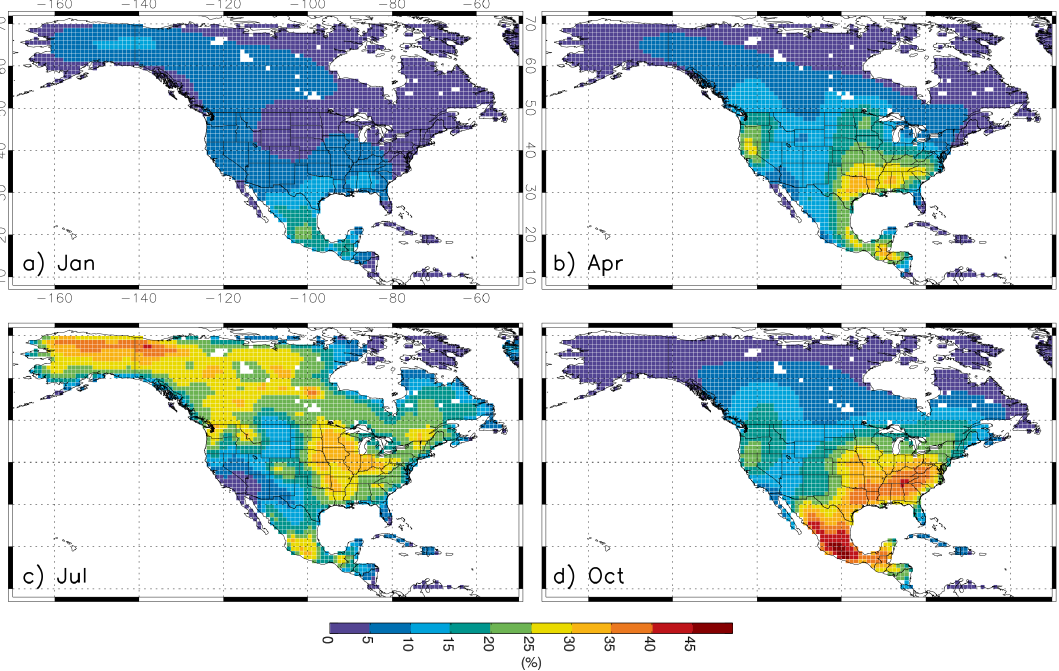
Figure 7. Weekly fractional flux uncertainty reduction over (a) January, (b) April, (c) July, and (d) October, for case 1 (1.57µm and 0.5ppm RRV error). Shown here are results from the first 4 weeks of each